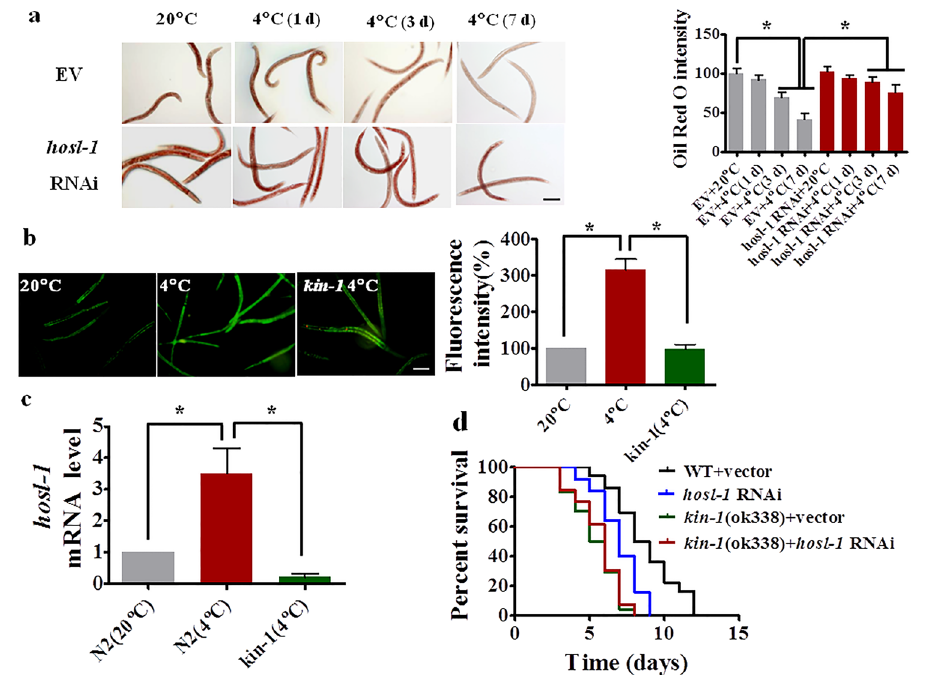
Figure 3. Fat mobilization is mediated by HOSL-1 during cold stress. ( a ) A representative image of lipid droplets using Oil Red O staining. Lipid hydrolysis was significantly inhibited in worms subjected to hosl- 1 ( RNAi ). * P < 0.05. Scale bar, 150 μ m. ( b and c ) The expression of Phosl-1 :: gfp ( b ) or the mRNA levels of hosl-1 ( c ) were up-regulated at 12 h after cold exposure. The mutation in kin-1 ( ok338 ) inhibited the expression of hosl-1 . The right panel represents relative GFP fluorescence intensity ( b ). * P < 0.05. Scale bar, 100 μ m. ( d ) hosl- 1 ( RNAi ) reduced the survival rate of worms at 4 °C. However, hosl-1 RNAi did not enhance cold susceptibility of kin-1 ( ok338 ) worms. P < 0.001 relative to WT with empty